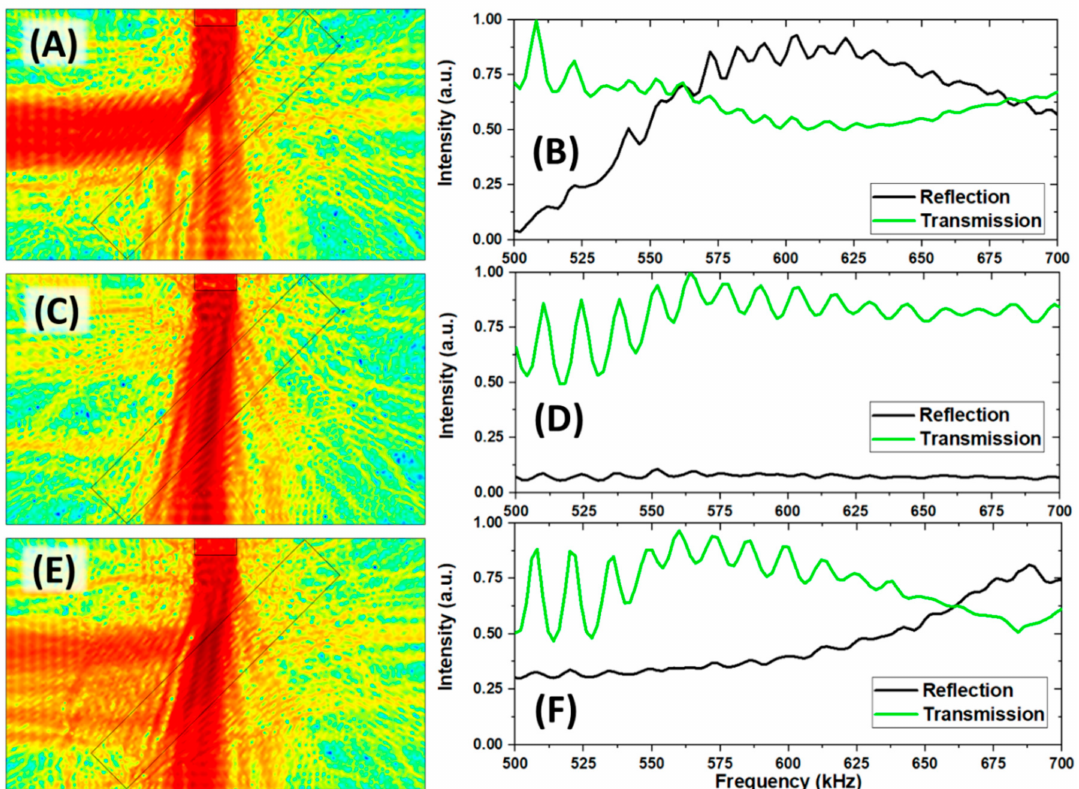
Figure 2. ( A ) Numerical simulation of acoustic separation by hydrogel in water presented by acoustic intensity field at 600 kHz and 20 ◦ C. ( B ) Simulated frequency spectra of the separated reflection and transmission at 20 ◦ C. ( C ) Numerical simulation of acoustic separation at 600 kHz and 32 ◦ C. ( D ) Simulated frequency spectra of the separated reflection and transmission at 32 ◦ C. ( E ) Numerical simulation of acoustic separation at 600 kHz and 39 ◦ C. ( F ) Simulated frequency spectra of the separated reflection and transmission at 39 ◦